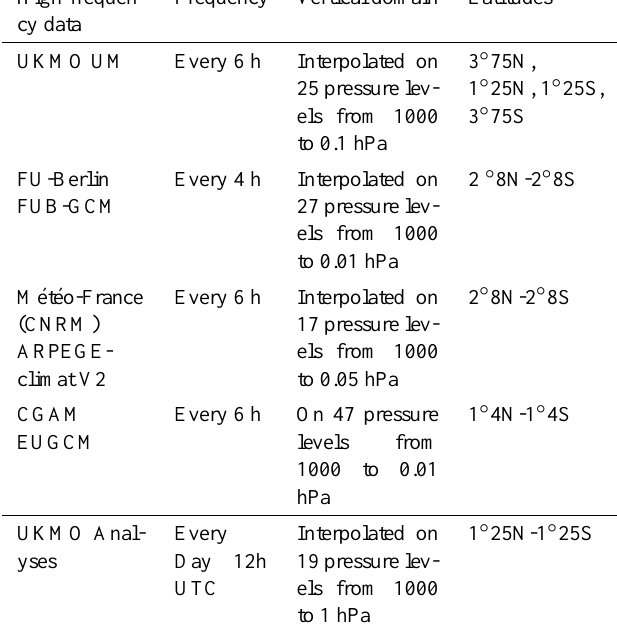
Table 1. Summary of the temporal series